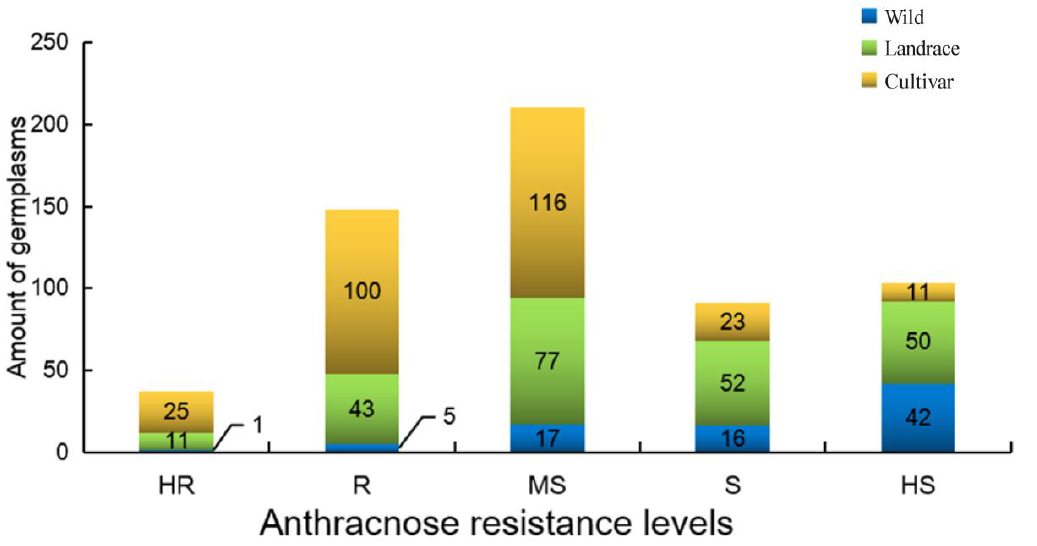
Figure 6. Distribution of the 589 soybean germplasm accessions according to the level of soybean anthracnose resistance. HR, highly resistant; R, resistant; MS, moderately susceptible; S, susceptible; HS, highly susceptible.